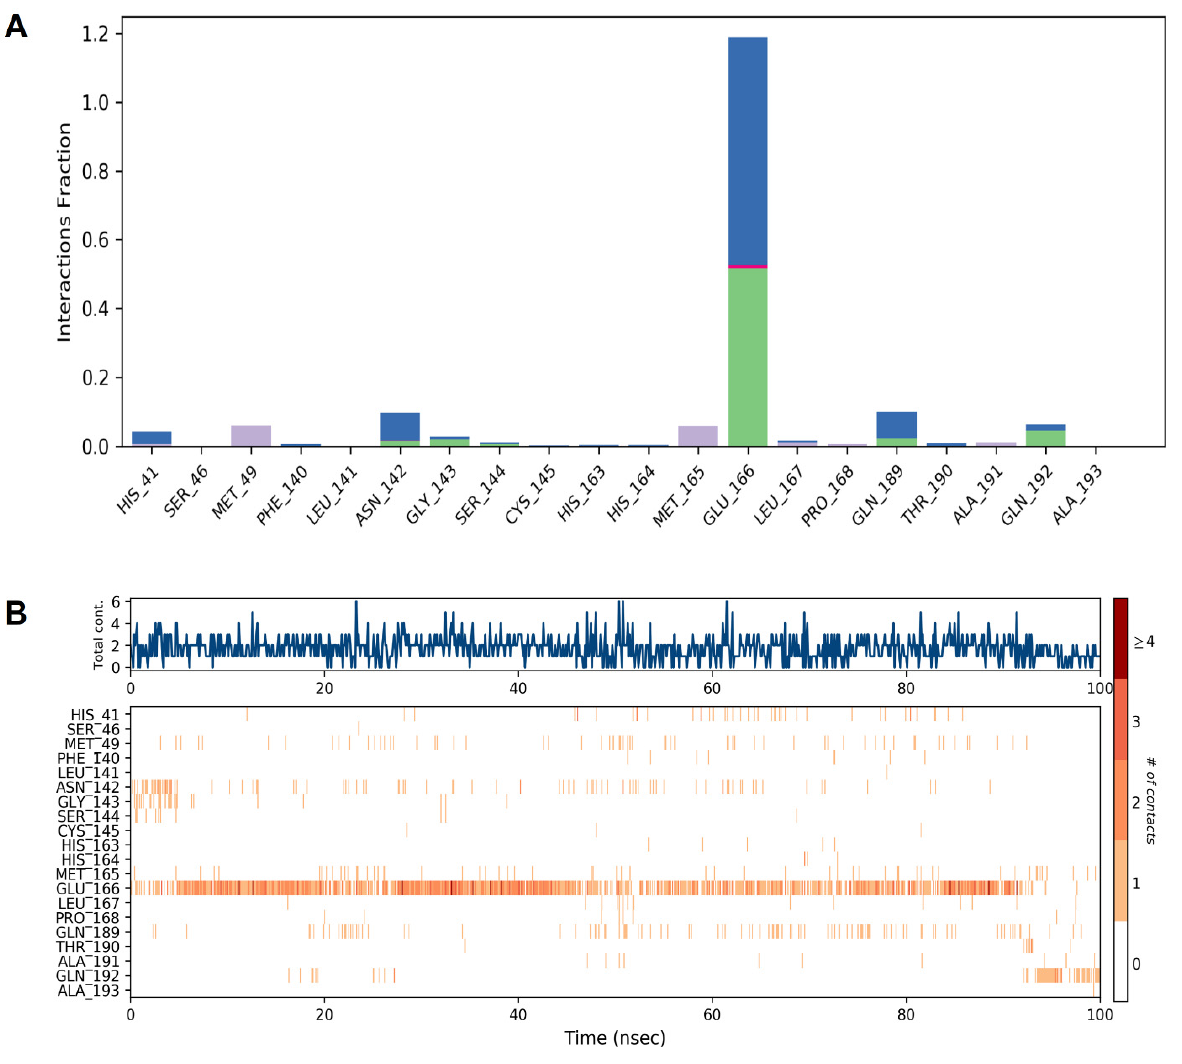
Figure 6. Illustration of the interaction fractions within the artemisinin and SARS-CoV-2 Mpro dur- ing a 100 ns simulation and the involved residues (( A ) and ( B ), respectively).